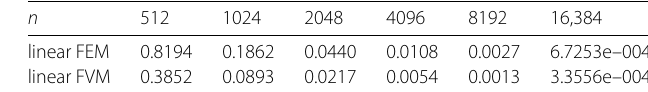
Table 2 The error in the relative discrete L 2 -norm for problem (5.1) with k = 200